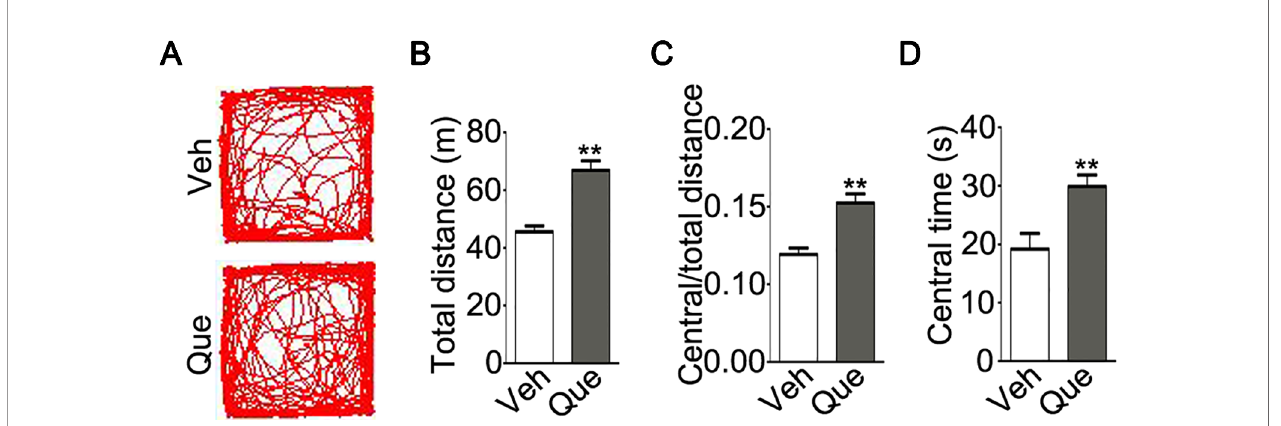
FIGURE 3 | Analyses of locomotor activity in socially isolated mice after quetiapine treatment. (A) An example of the travel pathway of tested mice in open fi eld test. Graphs show total distance (B) , ratio of central to total distance (C) and center time (D) in isolated mice treated with vehicle (Veh, n = 13) or quetiapine (Que, n = 13). Data are expressed as mean ± SEM. **P < 0.01.